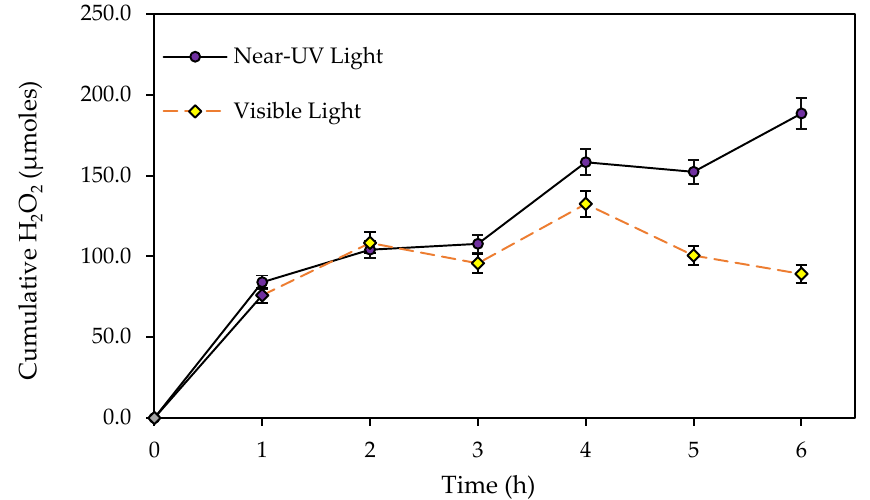
Figure 8. Cumulative H 2 O 2 as a Function of Irradiation Time in the Presence of 0.25 wt.% Pd-TiO 2 -